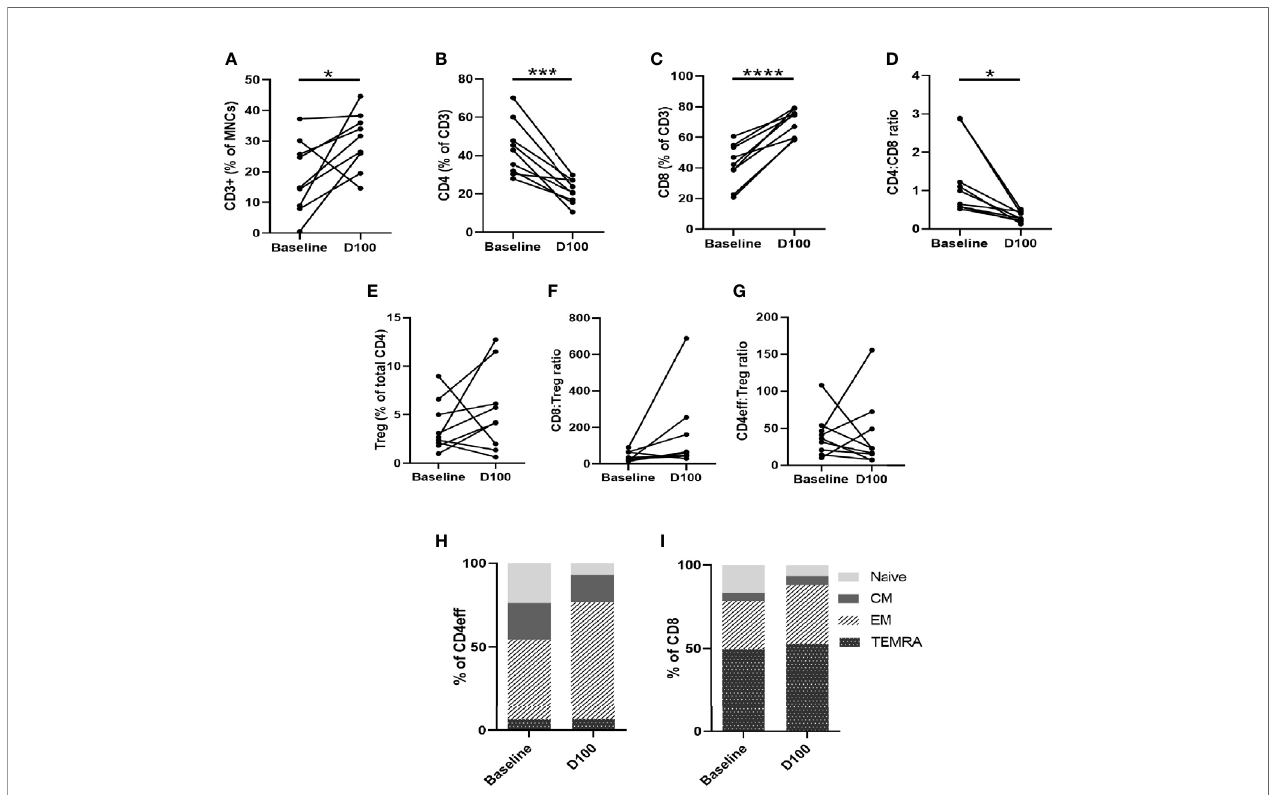
FIGURE 4 | Characterization of T cell subsets by fl ow cytometry of paired BM samples at diagnosis and D100 post-ASCT. (A) Change in frequency of total CD3, (B) CD4, (C) CD8, (D) CD4:CD8 ratio, (E) Tregs, (F) CD8:Treg ratio (G) CD4:Treg ratio. Ratios calculated using absolute numbers of populations in each sample. (H) Changes in CD4eff memory subtypes as de fi ned by CCR7 and CD45RA expression, (I) CD8 memory subtypes. Statistical analysis by paired Student ’ s t-tests *p < 0.05, ***p < 0.001, ****p <